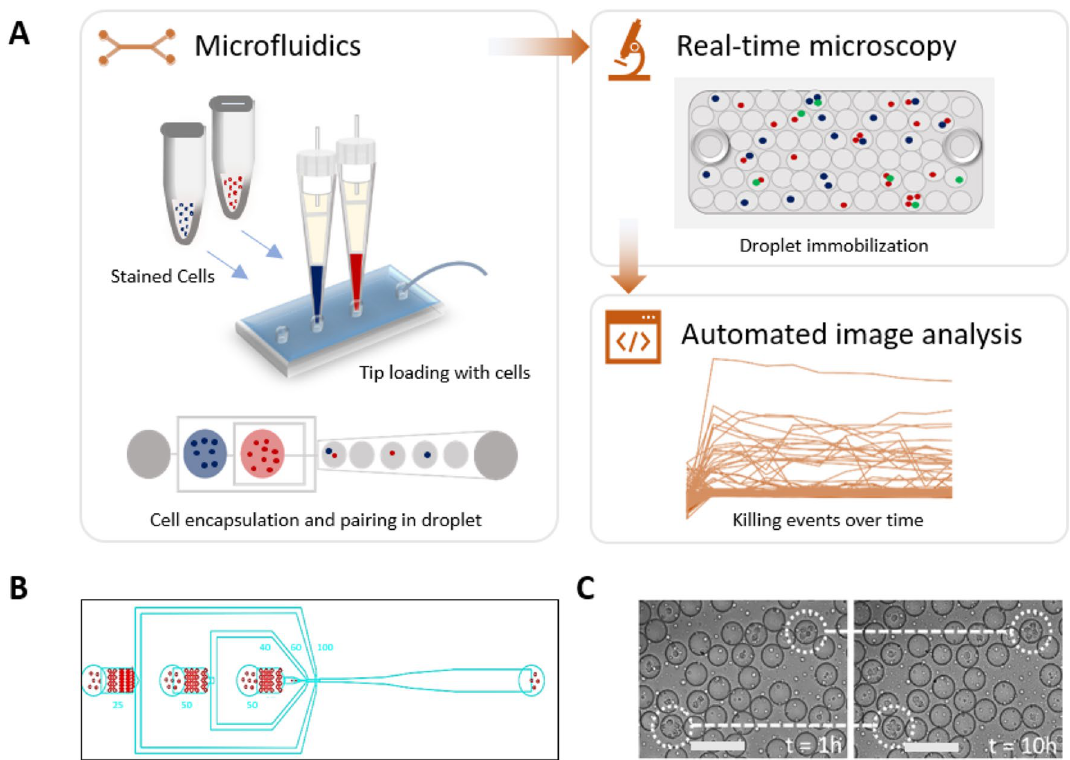
Figure 1. Experimental setup of high-throughput droplet-based cytotoxicity platform. ( A ) Experimental schematics showing cytotoxicity platform that combines (i) droplet generation and cell pairing using microfluidics, (ii) droplet immobilization for real-time microscopy, (iii) automated image analysis using custom- made MATLAB script to allow unbiased and high throughput detection of cytotoxic events. Stained NK cells and K562 cells were loaded into the chip using 200 µL pipette tips and encapsulated into droplets using a 3-inlet microfluidic chip. The viability dyes were included within the cell medium. The immobilized droplets